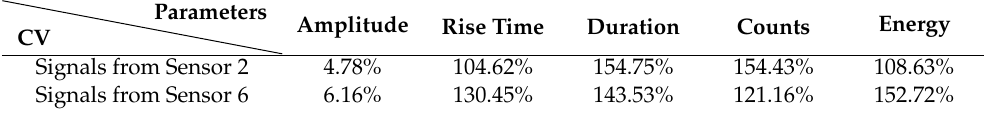
Table 6. Coefficients of variance (CV) of AE amplitude, energy, duration, counts, and energy. Parameters CV